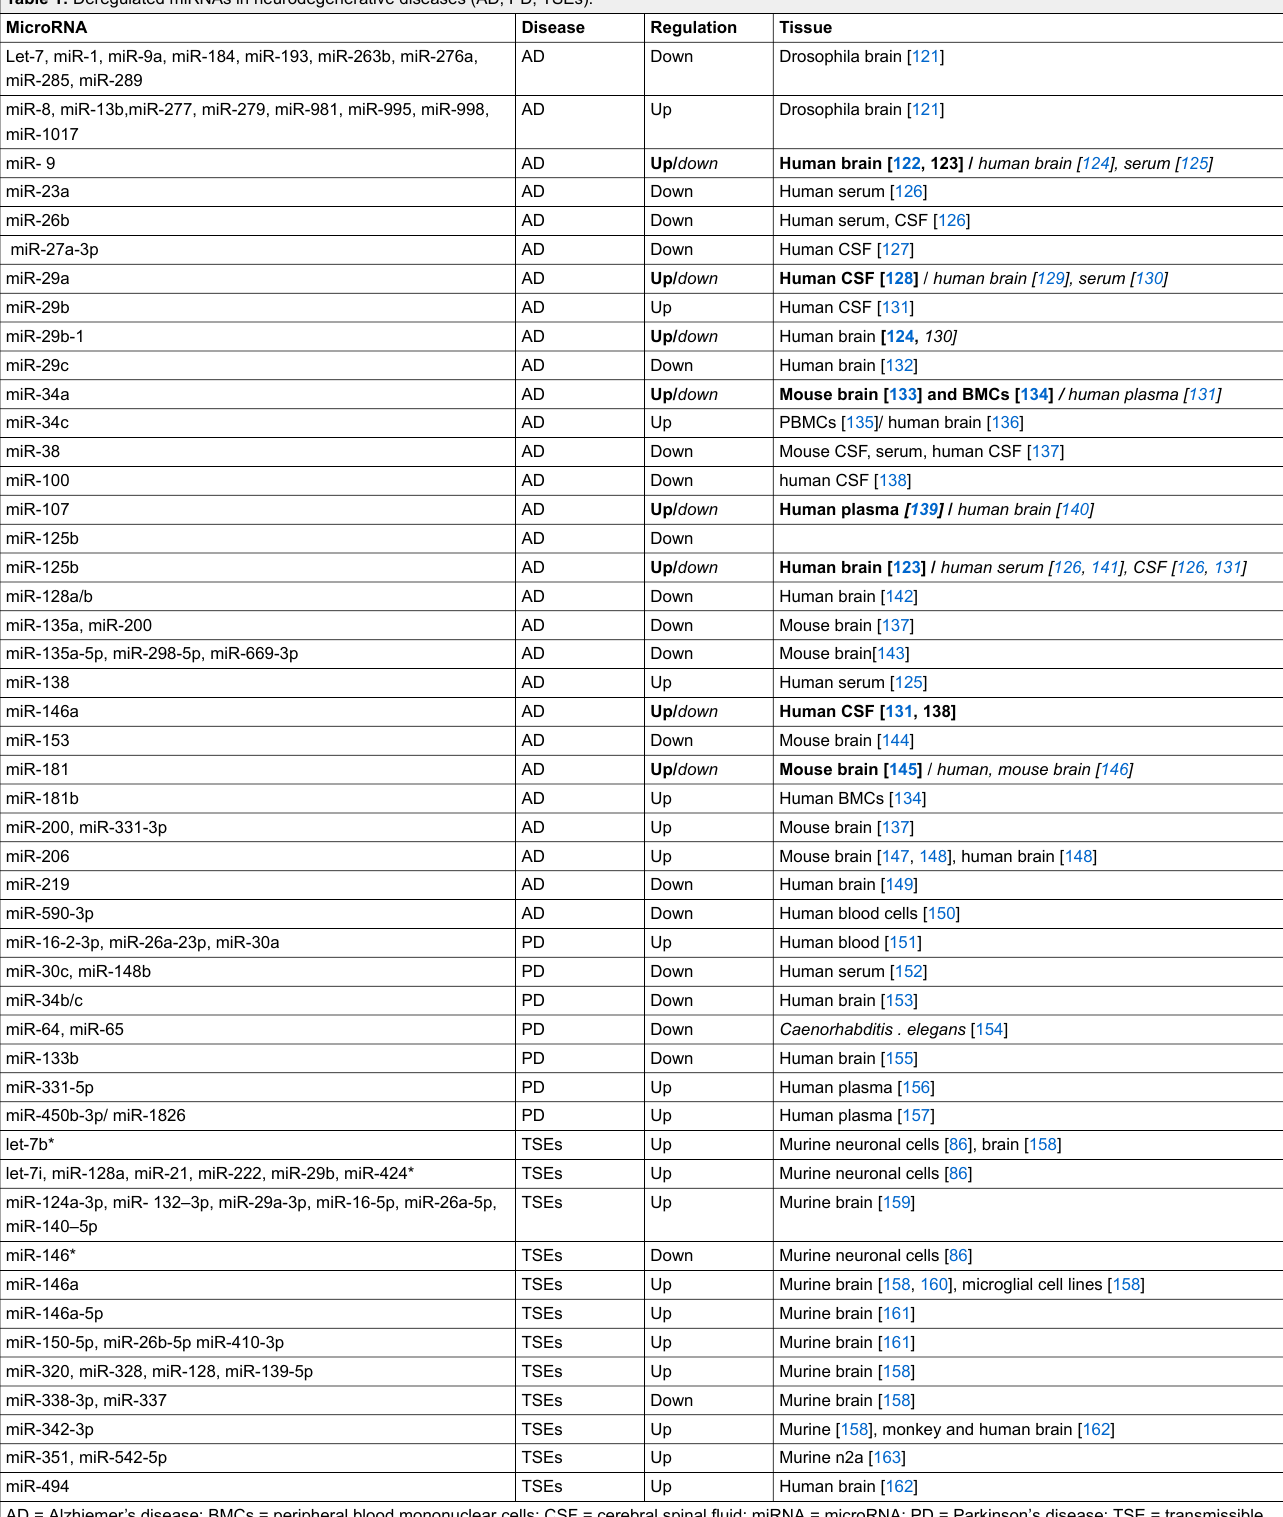
Table 1: Deregulated miRNAs in neurodegenerative diseases (AD, PD, TSEs). MicroRNA Disease Regulation